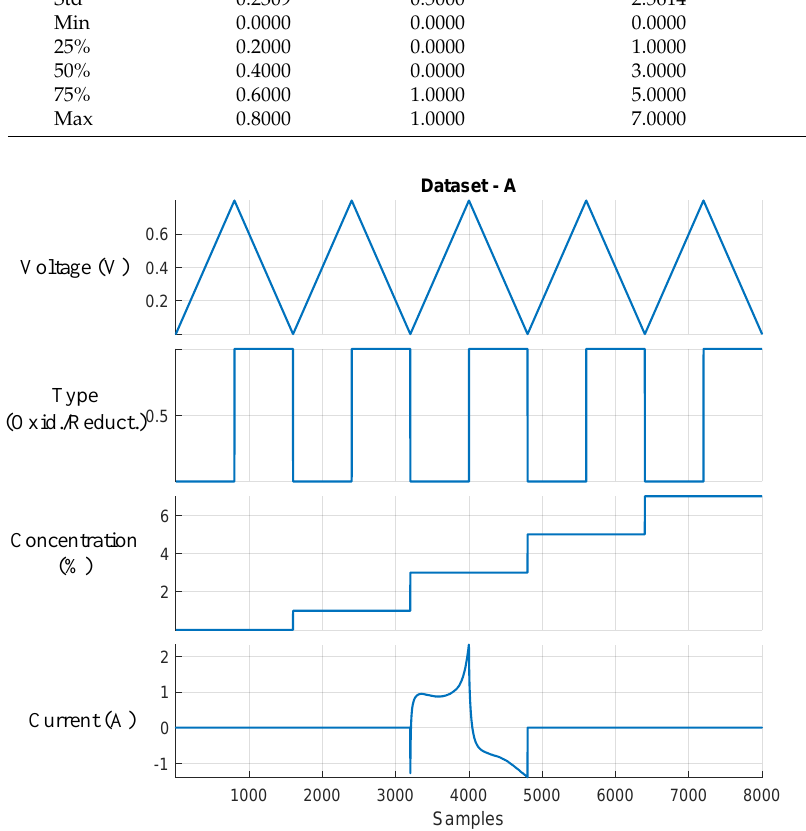
Figure 2. Distribution plot of Dataset